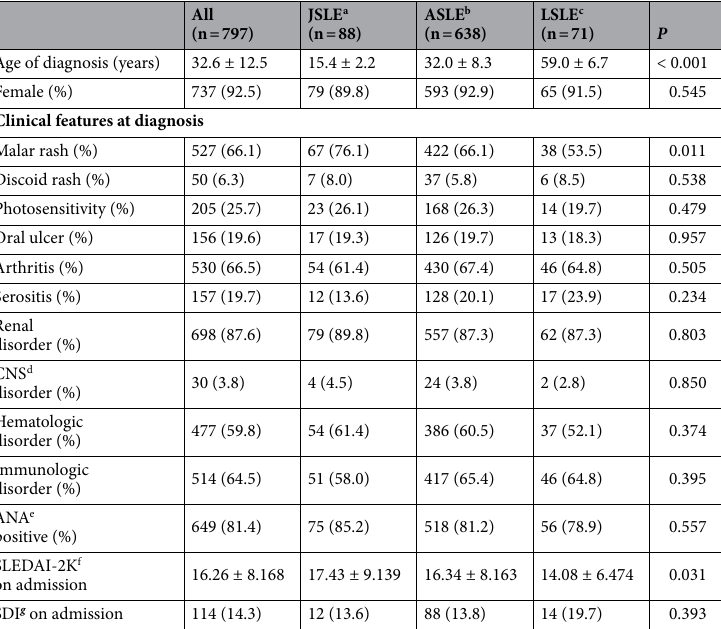
Table 1. Basic clinical features of patients from each age-onset group. a JSLE juvenile-onset SLE; b ASLE adult- onset SLE; c LSLE late-onset SLE; d CNS central nervous system; e ANA antinuclear antibody; f SLEDAI-2 K SLE Disease Activity Index 2000; g SDI Systemic Lupus International Collaborating Clinics/American College of Rheumatology Damage